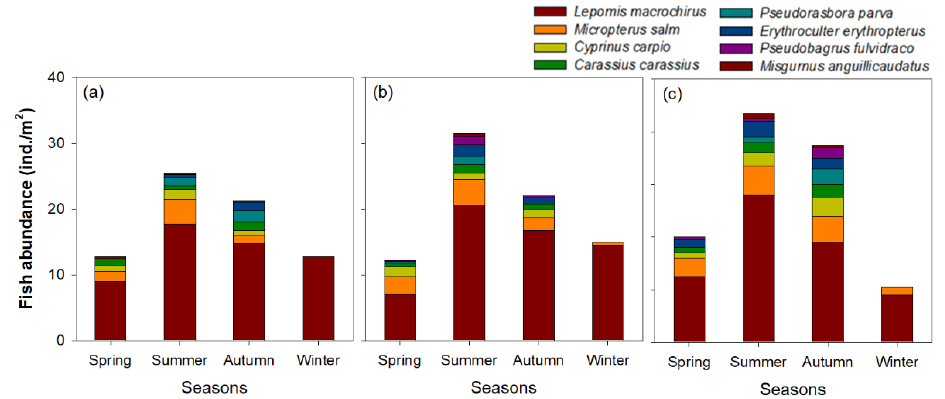
Figure 5. Seasonal distributions of fish communities in ( a ) Upo Wetland, ( b ) Jangcheok Wetland, and ( c ) Beongae Wetland.